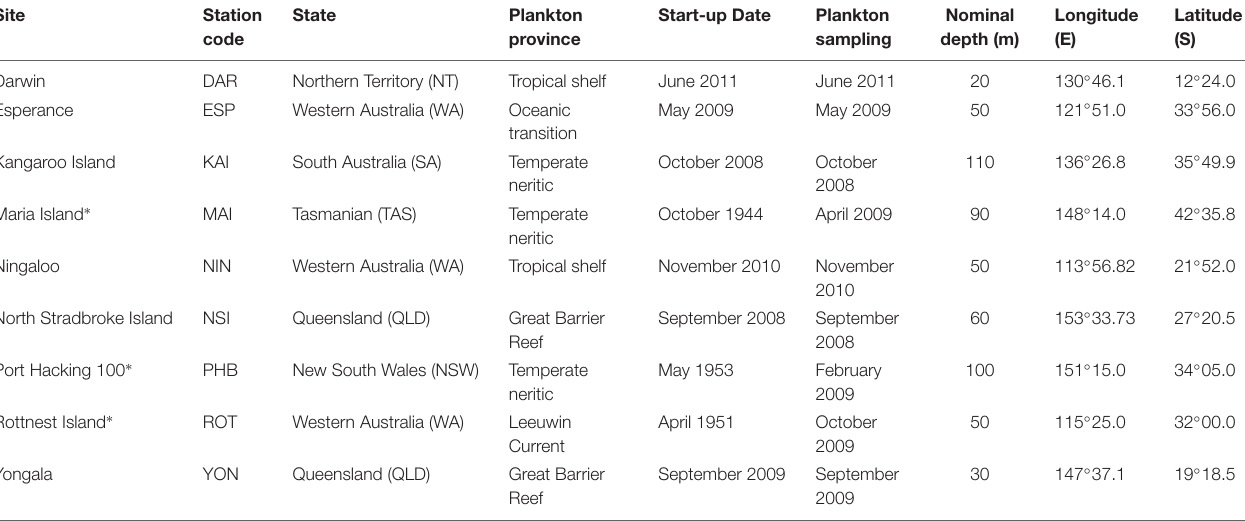
TABLE 1 | National Reference Station codes, depths, and locations